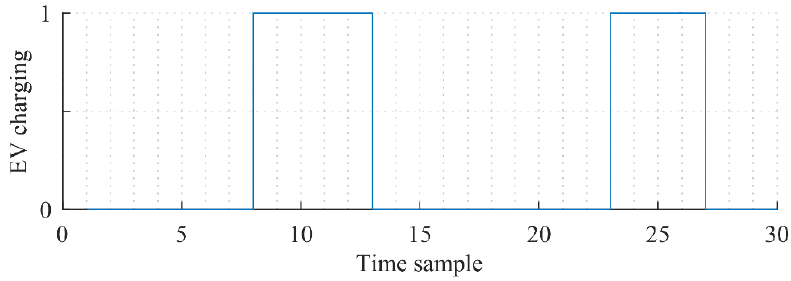
Figure 12. EV charging profile — case 4.